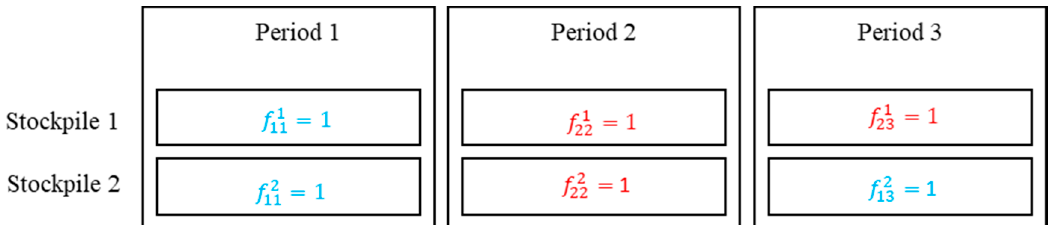
Figure 9. After setting to 1 some variables, there was another LP round with changes, and a possible solution of this IOSEP problem was found. When product 1 is designated to stockpile, the variable is blue, otherwise, if product 2 is designated to stockpile, the variable is red.